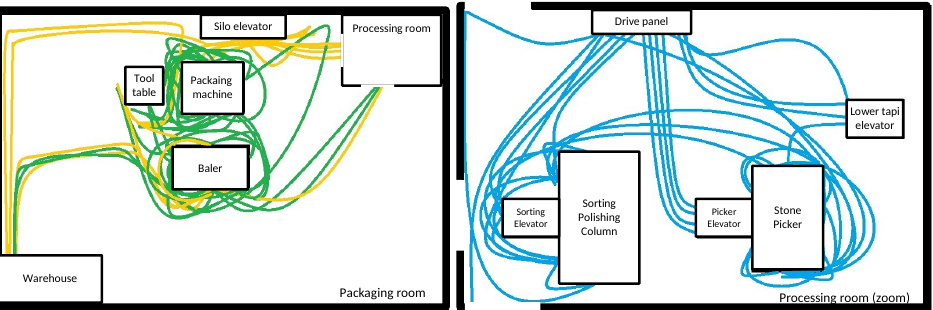
Figure 4. Spaghetti diagram of setup in the initial phase. Each color represents a different operator. During the machine setup, the operator responsible for processing, shown in blue, covered 448 steps. In this work, each step of the operator was considered equivalent to 60 cm, so the processing operator covered about 269 m. The operator responsible for the packaging and baling operations, represented in green, travelled about 453 m. Finally, the repairperson, represented in yellow, moved approximately 143